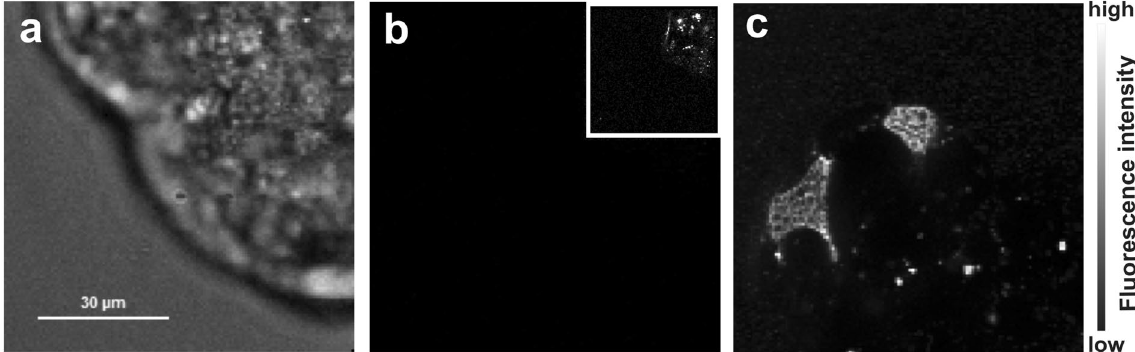
Figure 15. ( a ) Bright field image of chosen cell region to be injected, ( b ) fluorescence image of cell region before injection, (inset) fluorescence image before injection boosted 40 times for visibility of autofluorescence, ( c ) fluorescence image of cell region after injection showing AlexaFluor647 fluorescence in two different injection points.